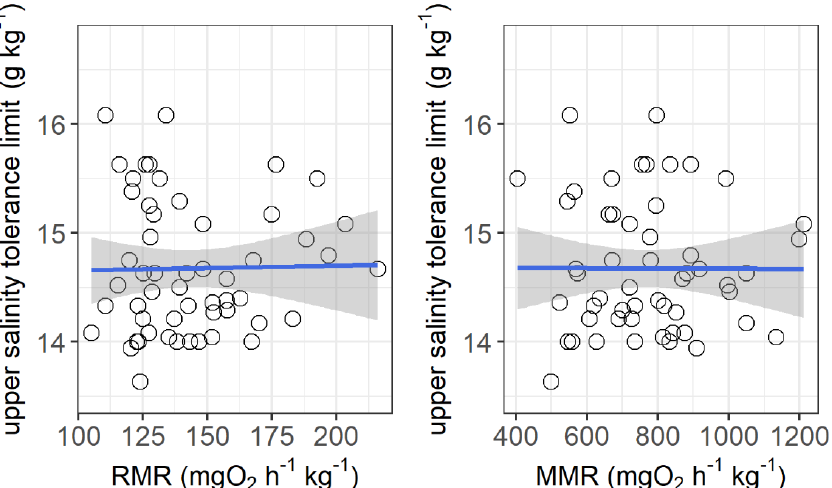
Figure 4. Correlations between upper salinity tolerance limit (g kg − 1 ) and resting metabolic rate (RMR, mg O 2 h − 1 kg − 1 ) and maximum metabolic rate (MMR, mg O 2 h − 1 kg − 1 ) of grass carp. RMR: r 2 < 0.001, p = 0.90; MMR: r 2 < 0.001, p = 0.98. The data are shown by the circles and the regressions are shown by the blue line.